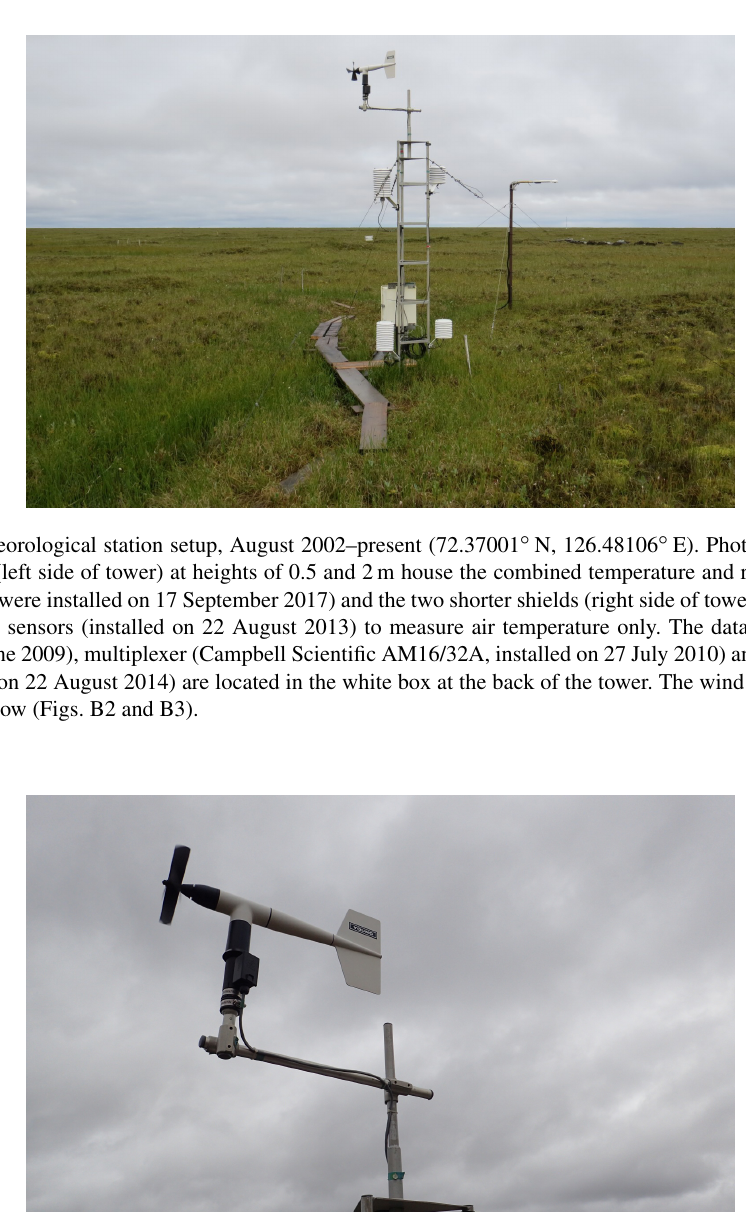
Earth Syst. Sci. Data, 11, 261–299,